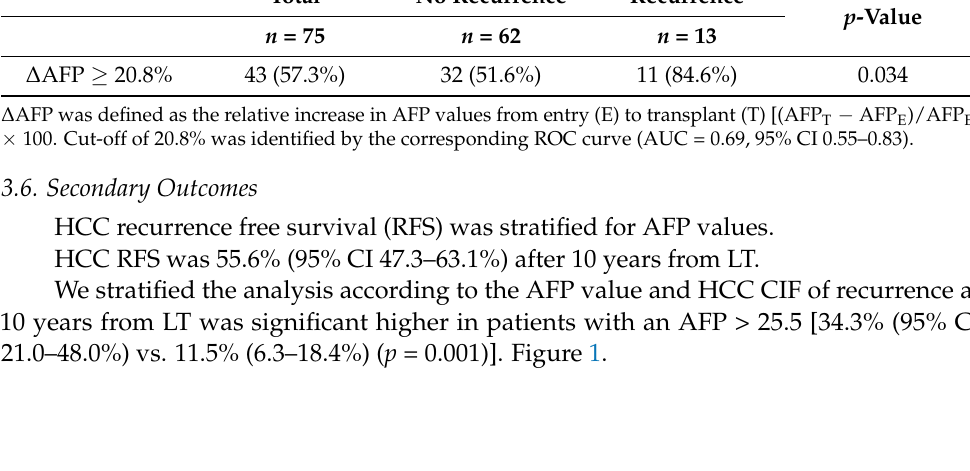
Table 3. The association between ∆ AFP and recurrence in patients with increased AFP values at transplant.